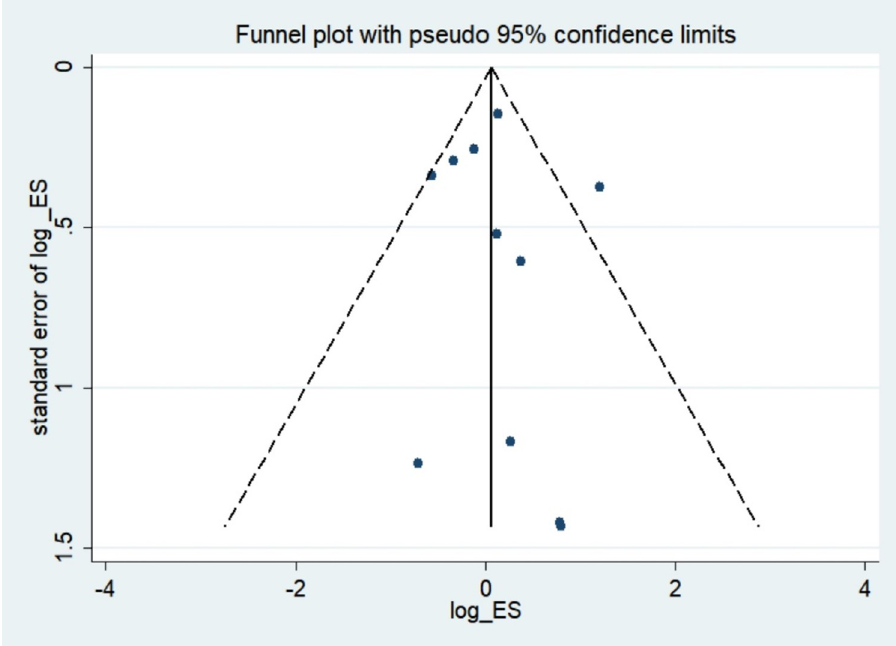
Fig 11. Funnel plot of congenital